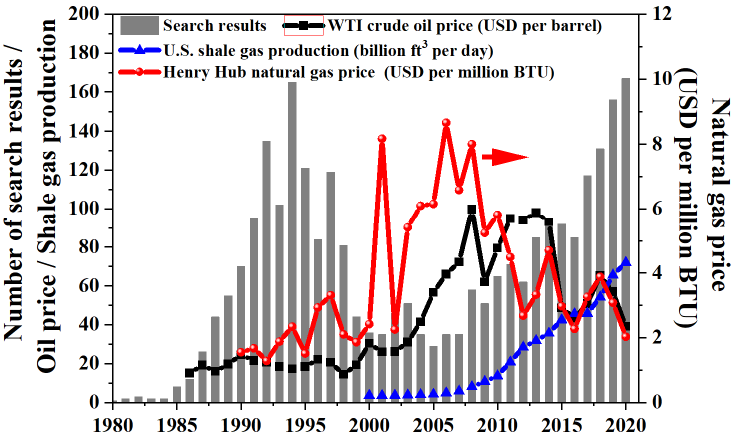
Figure 2. Comparison between the chronological distribution of search results using the keyword set (a) (oxidative, methane and coupling) and the prices of WTI crude oil (in USD per barrel) [3] and Henry Hub natural gas (in USD per million BTU) [4]; and the production of U.S. shale gas (in billion ft 3 per day) [5].